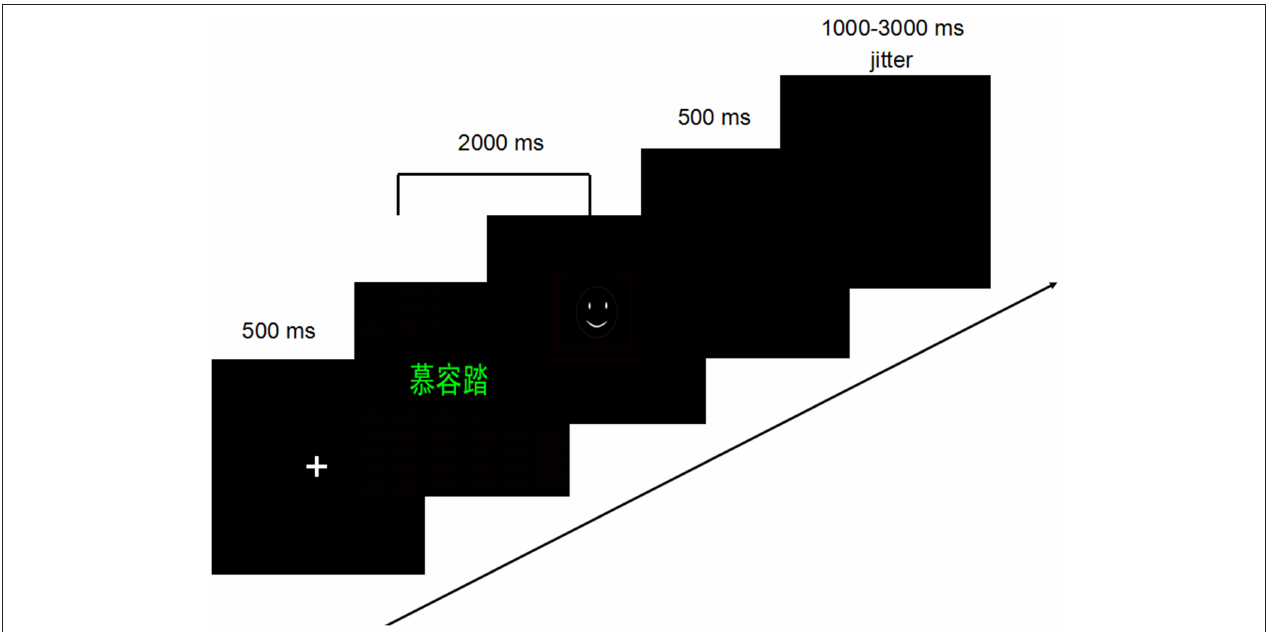
FIGURE 1 | The procedure of addiction Stroop task in present study.